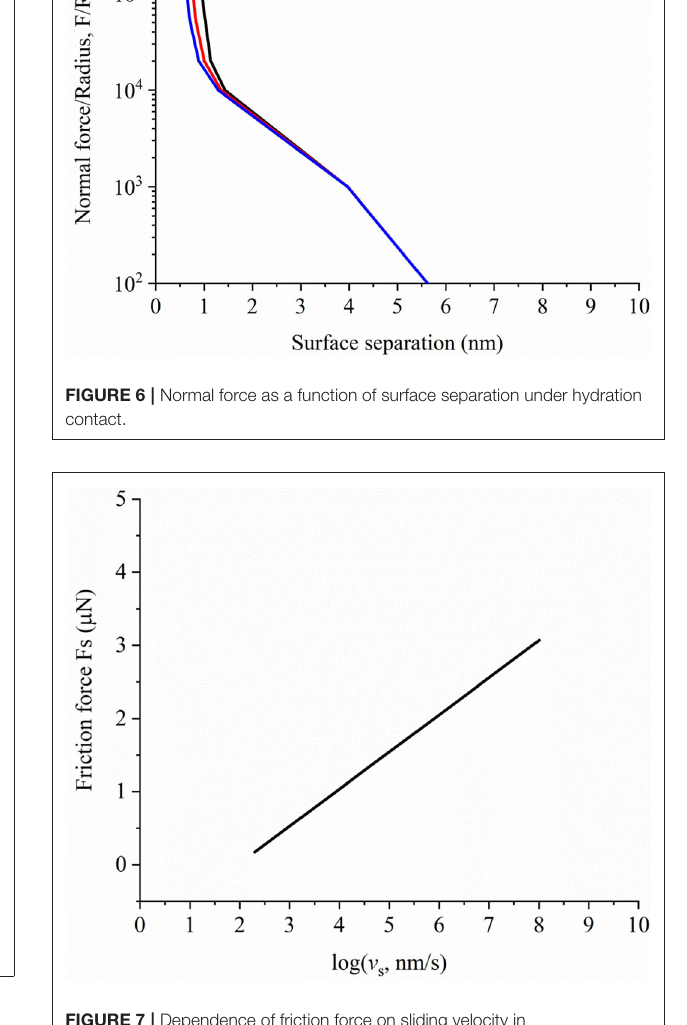
FIGURE 7 | Dependence of friction force on sliding velocity in hydration-lubricated contact under a load of 1